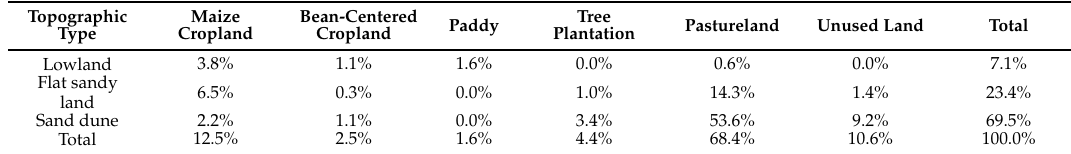
Table 2. Cross tabulation of object-based and GIS-based classification